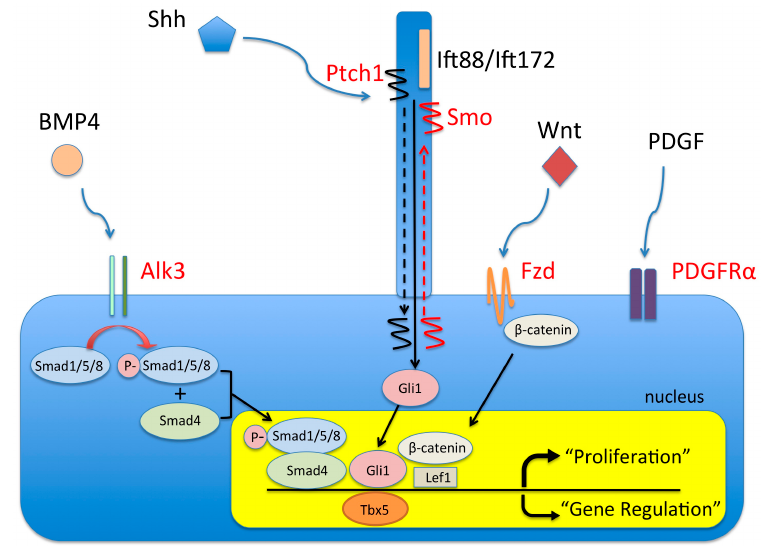
Figure 7. Model of a posterior SHF-DMP precursor cell. This simplified cartoon of a DMP precursor cell with a protruding primary cilium shows pathways and factors known to be involved in pSHF/DMP-dependent atrioventricular septation.